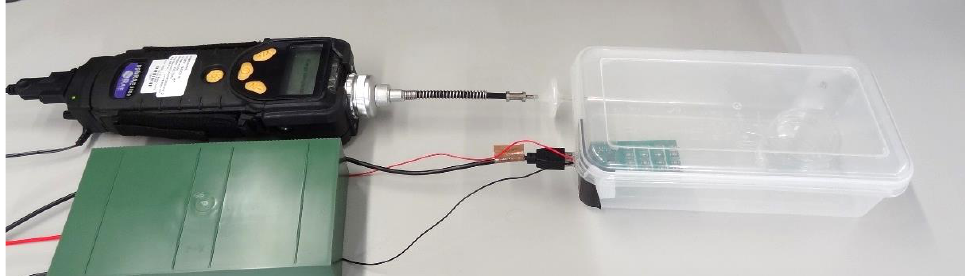
Figure 2. Measurement setup composed of a PID, the redundant power supply for the eNose, a transparent box containing the eNose, and a small glass plate to deposit the volatile in liquid